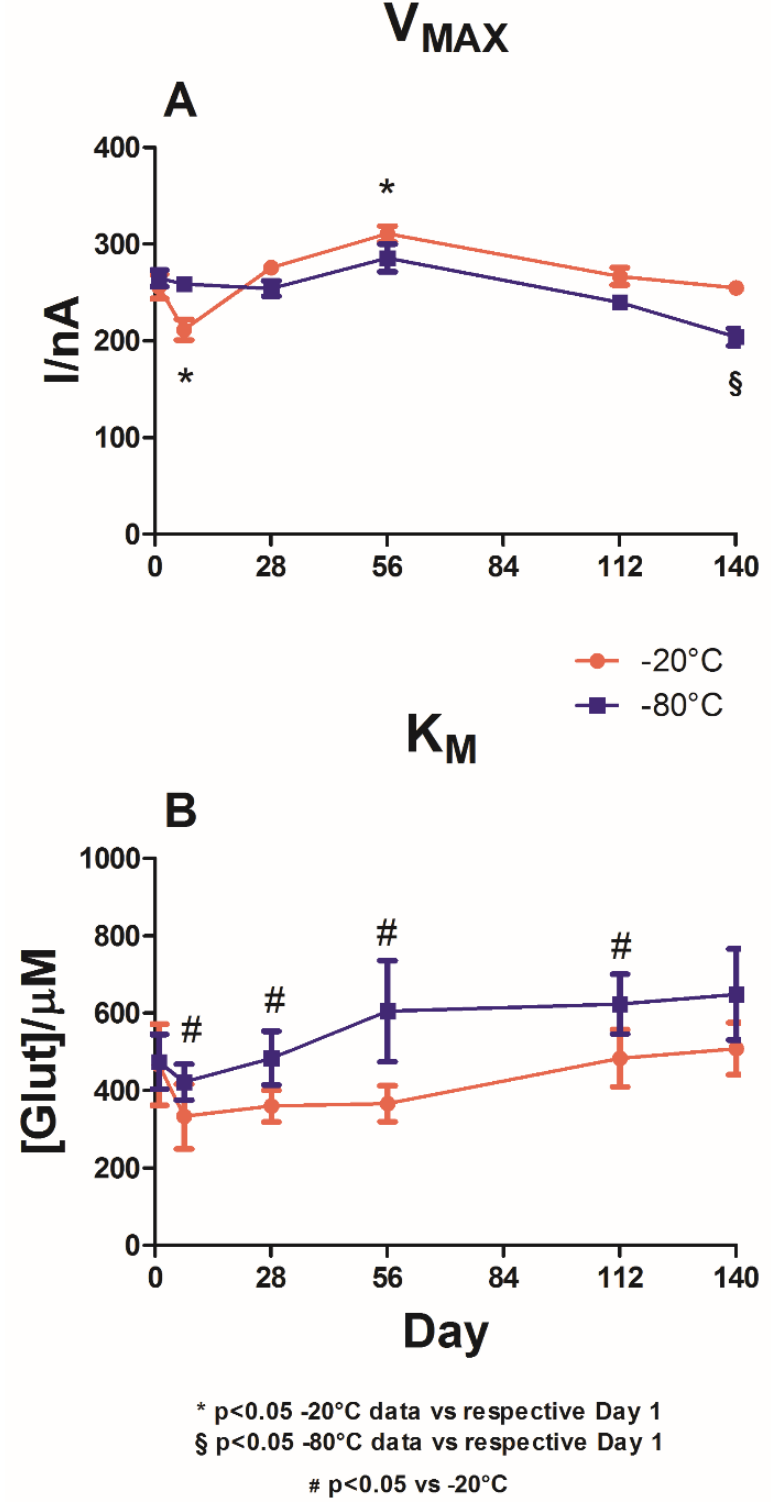
Figure 3. Graph describing the variations in V MAX of 140 days for the biosensor design Pt c /PPD/PEI(1%) 2 /GlutOx 5 /GLY(1%) when stored at −20 °C (red plot) and −80 °C (blue plot). The subscript number represents the number of deposition steps, while brackets report the concentrations of the component. Pt c : Pt cylinder 1 mm long, 125 µm in diameter; GluOx: L-glutamate oxidase; PPD: poly-o-phenylenediamine; PEI: polyethyleneimine; GLY: